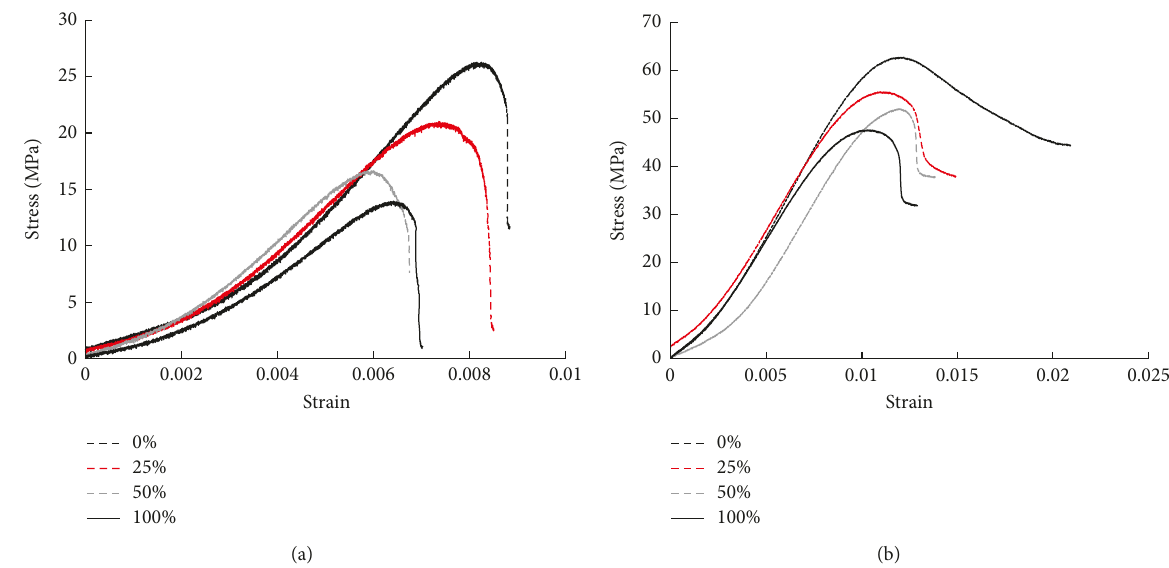
Figure 1: Stress-strain curves of the samples with different water contents. Uniaxial (a) and triaxial (b) compression tests under confining pressure 7.5 MPa.